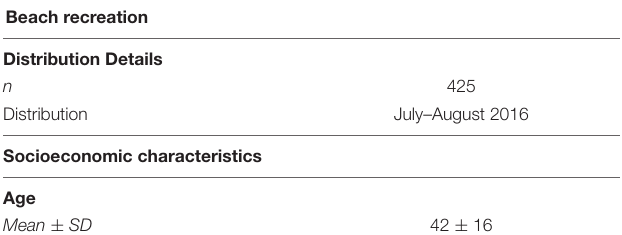
TABLE 4 | Summary of the main characteristics and results of the questionnaires distributed among beach goers in the Nerbioi estuary. Beach